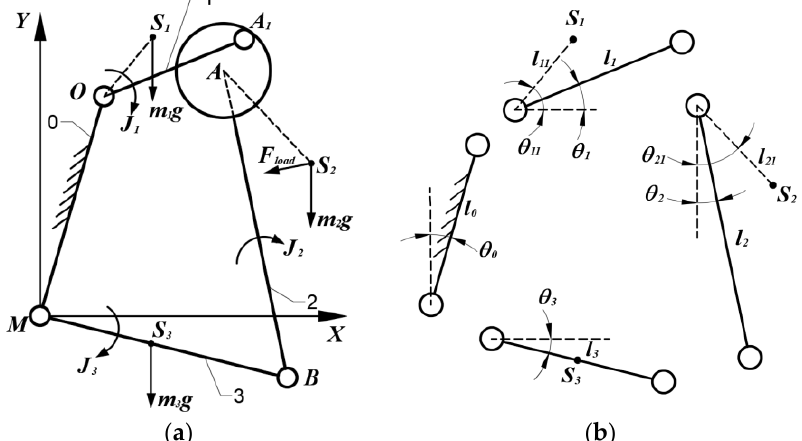
Figure 2. Working mechanism of the jaw crusher with clearance. ( a ) Demonstration of mass, rotational inertia and load; ( b ) Demonstration of length and angle.